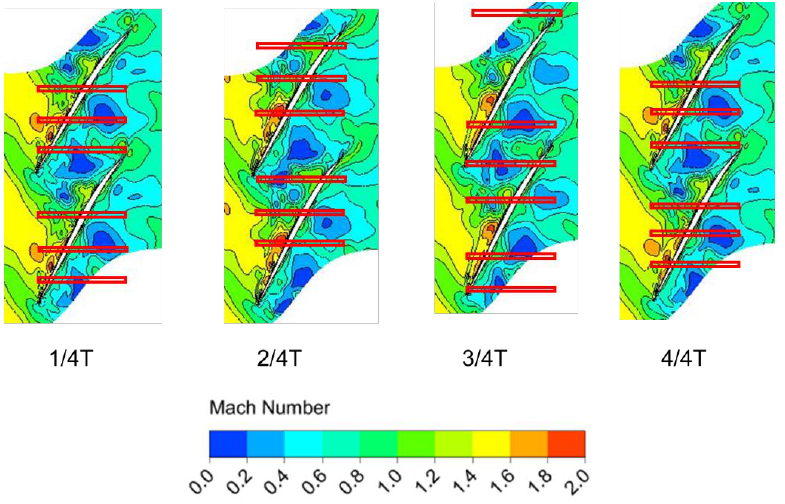
Figure 19. Mach number contours at 99% span in an unsteady period for the casing treatment case of 3 slots per passage.